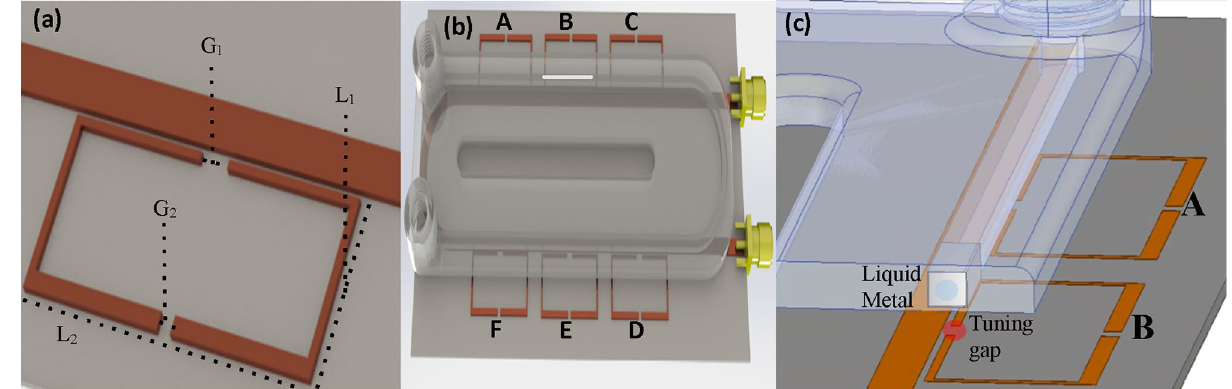
Figure 1. ( a ) The individual resonator dimensions, where G 1 = 2 mm, G 2 = 1 mm, L 1 = 9.5 mm, and L 2 = 21 mm, ( b ) the designed sensor array and microfluidic channel with liquid metal positioned at resonator B and ( c ) a cropped resonator showing the liquid metal and resonator coupling alignment. Images were rendered by Solidworks software, 2019 edition (https:// www. solid works.